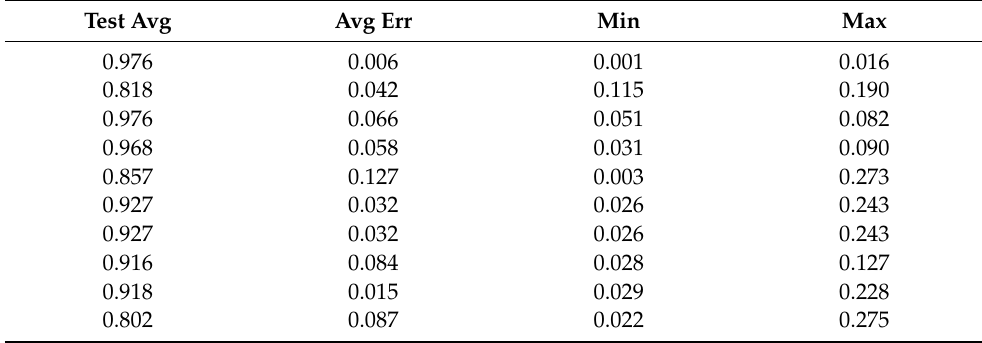
Table A22. Set 1, trials 11–20 data (actual PR